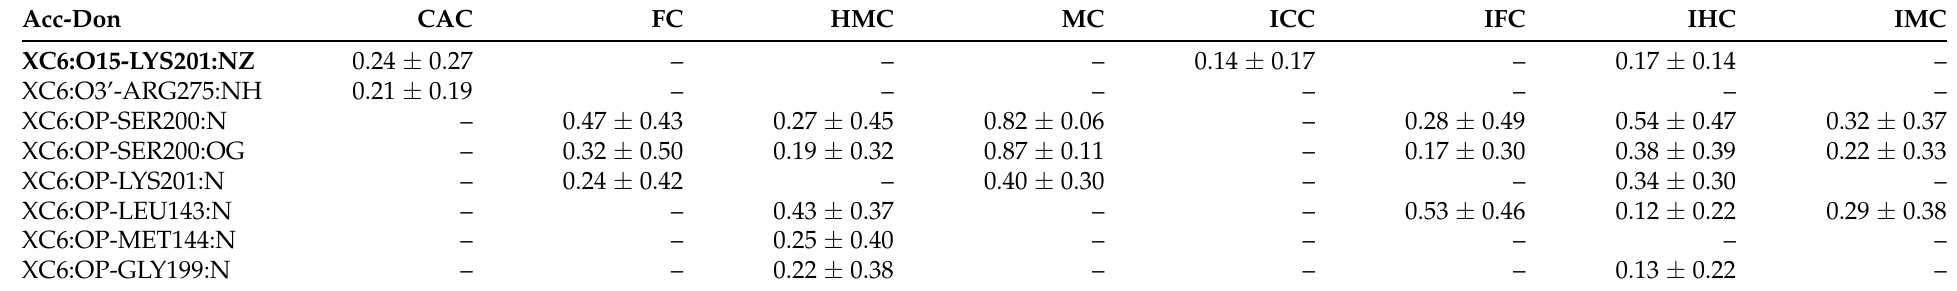
Table 4. Hydrogen bond probabilities between the TDG protein and the oxidised methyl-cytosine XC. Only hydrogen bonds with a probability of at least 0.2 in at least one of the systems are shown. The hydrogen bond with the oxygen atom of the methyl group is highlighted in bold.